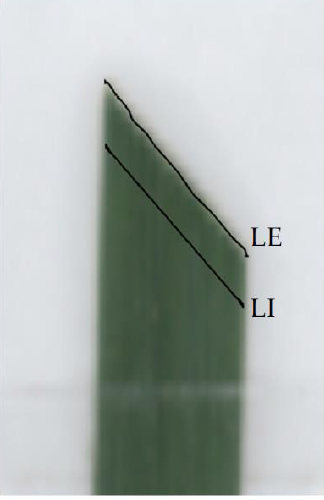
Figure 2. Leaf tip damage level = 1.07.